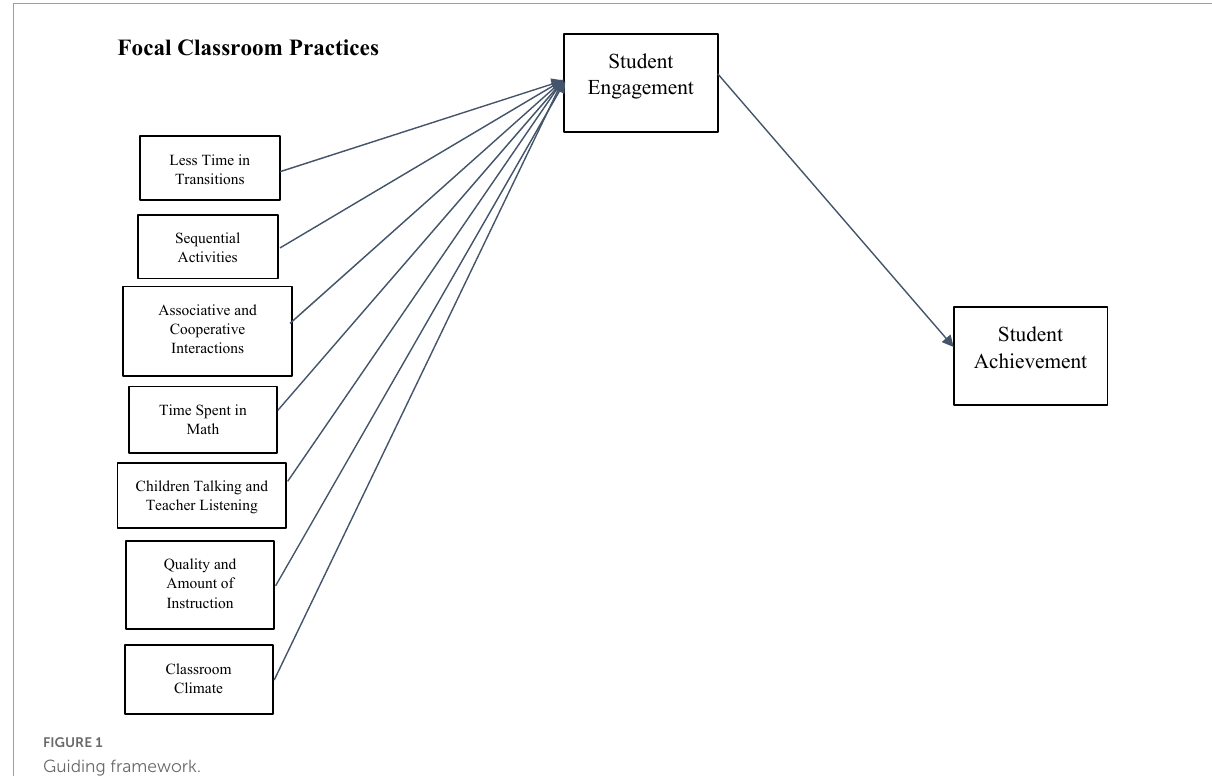
FIGURE1 Guiding framework.